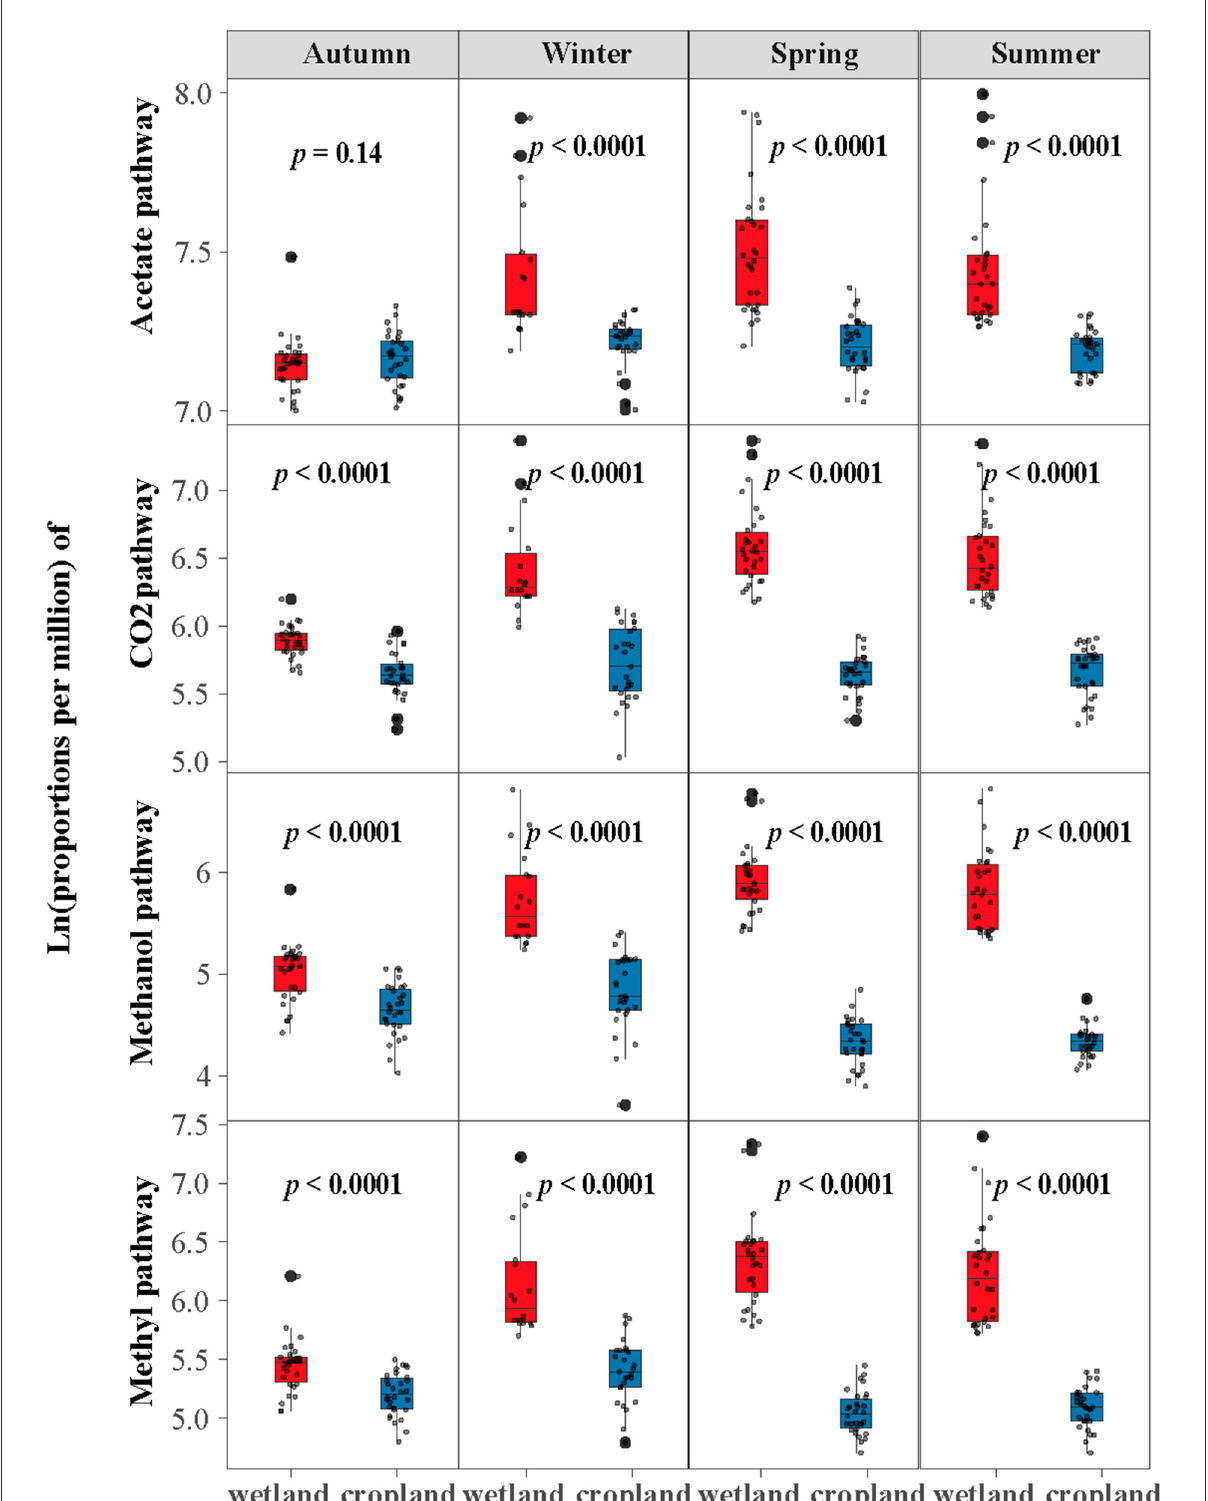
FIGURE2 Cultivation impacts the proportions of genes in four methane production pathways across seasons. Log-transformation with base e was used before